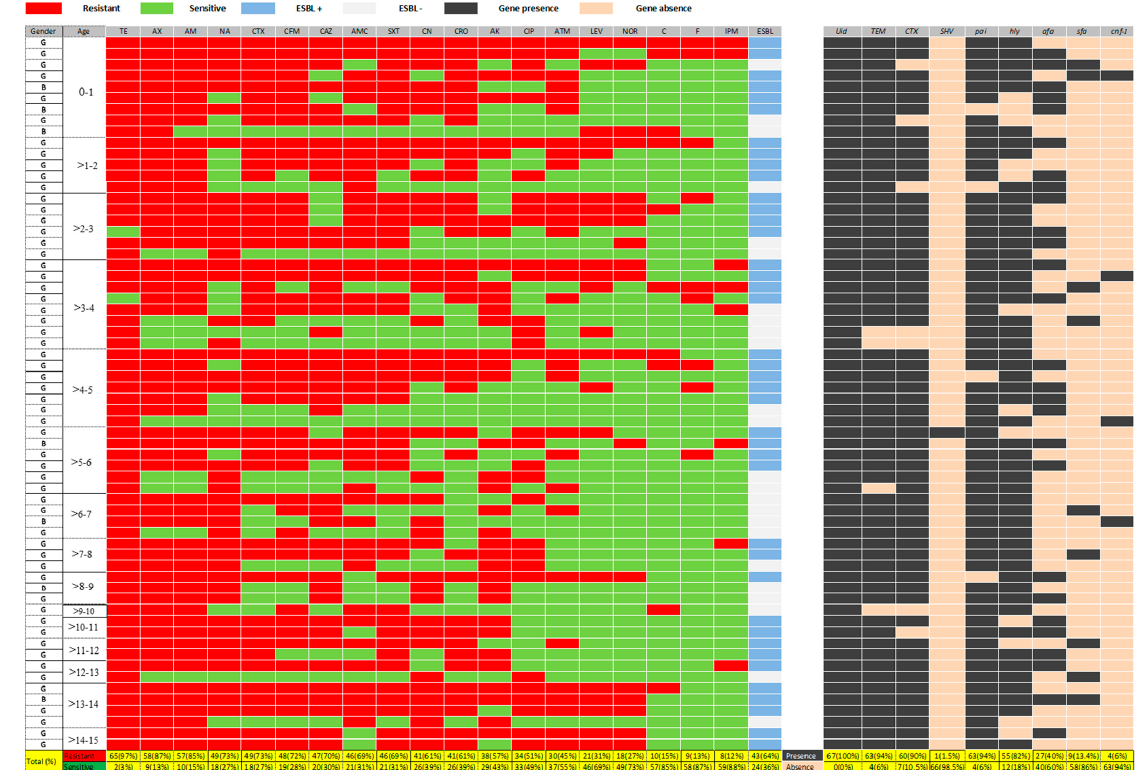
Figure 2. The prevalence of isolated E. coli and details of each strain for antibiotic resistance profiles and genes of both ESBL production and virulence factor. The red color of cells indicates that E. coli strains are resistant to antibiotics while the green color refers to E. coli strains that are sensitive to antibiotics. Furthermore, the blue color cells indicate that E. coli are ESBL producers by the DDST, whereas the white-darker color cells are for non-ESBL producer E. coli . Moreover, the black color cells indicate that E. coli strains have the marker genes while orange colors refer to E. coli strains which do not possess the marker. In addition, the yellow colors refer to the total and percentage for these above parameters. Each cell is for the individual bacteria. Keys: antibiotics include; TE: Tetra-